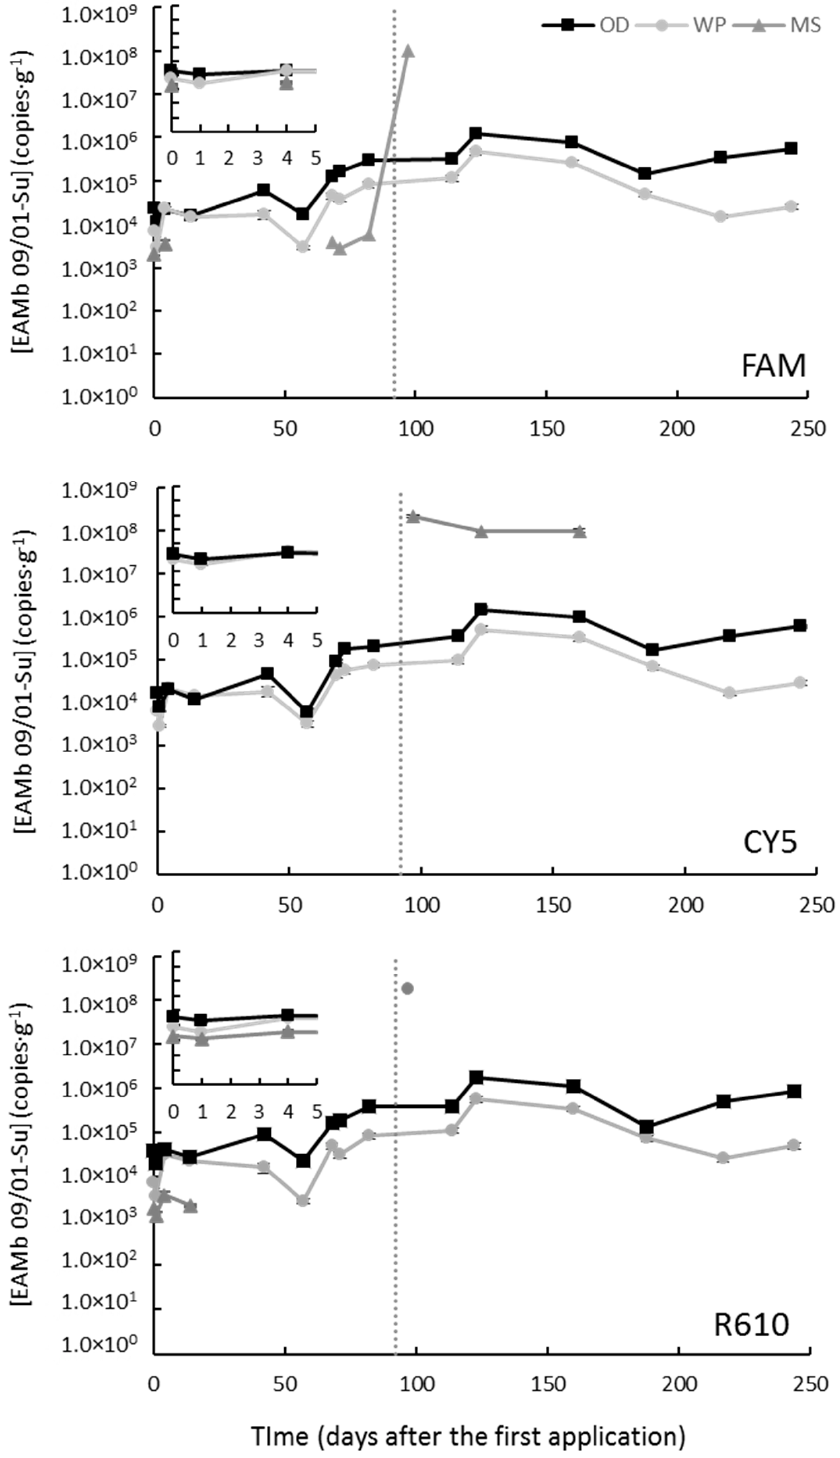
Figure 1. Concentrations of Metarhizium brunneum strain EAMb 09/01-Su in the substrate when applied as different formulations in a field trial at Mont-Roig del Camp. The different panes correspond to the three different markers, labeled as denoted within each pane. Missing data are measurements below the limit of detection. The vertical dotted line indicates the time of the second application, and the inserts show the first 5 days after the first application in detail. FAM stands for 6-carboxyfluorescein; CY5, for cyanine-5; and R610 for LightCycler ® Red